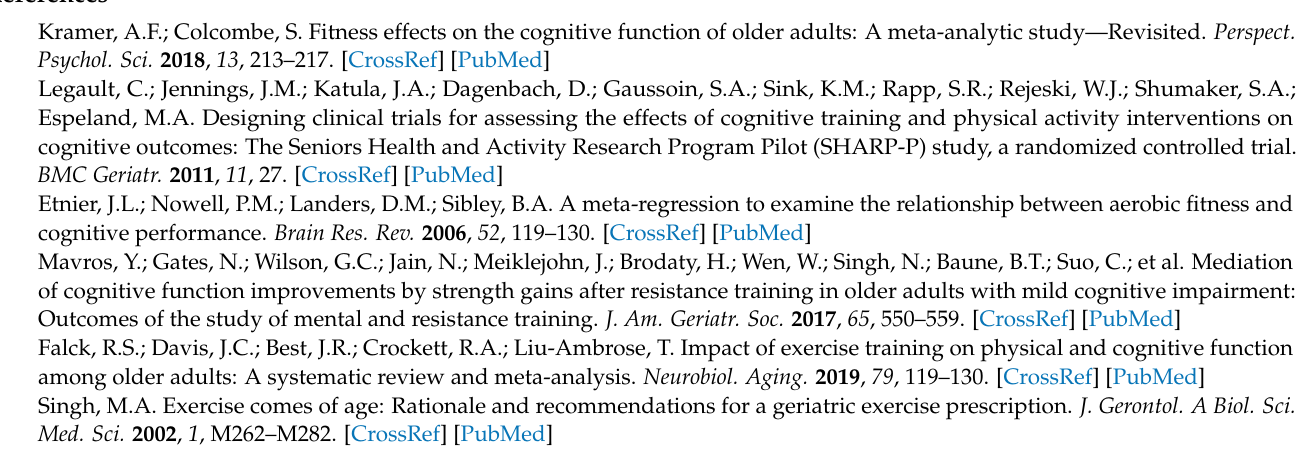
Figure S3: Lower body strength and errors committed in the VAT; Figure S4: Irisin and TMT B results changes; Figure S5: Irisin and errors committed in DMS changes; Figure S6: BDNF and reaction time Table S2: Between-groups (SCB vs RT) comparisons of delta values (just after training program minus baseline); Table S3: Within-group (just after training program minus baseline) comparisons in the RT group; Table S4: Within-group (just after training program minus baseline) comparisons in the SCB